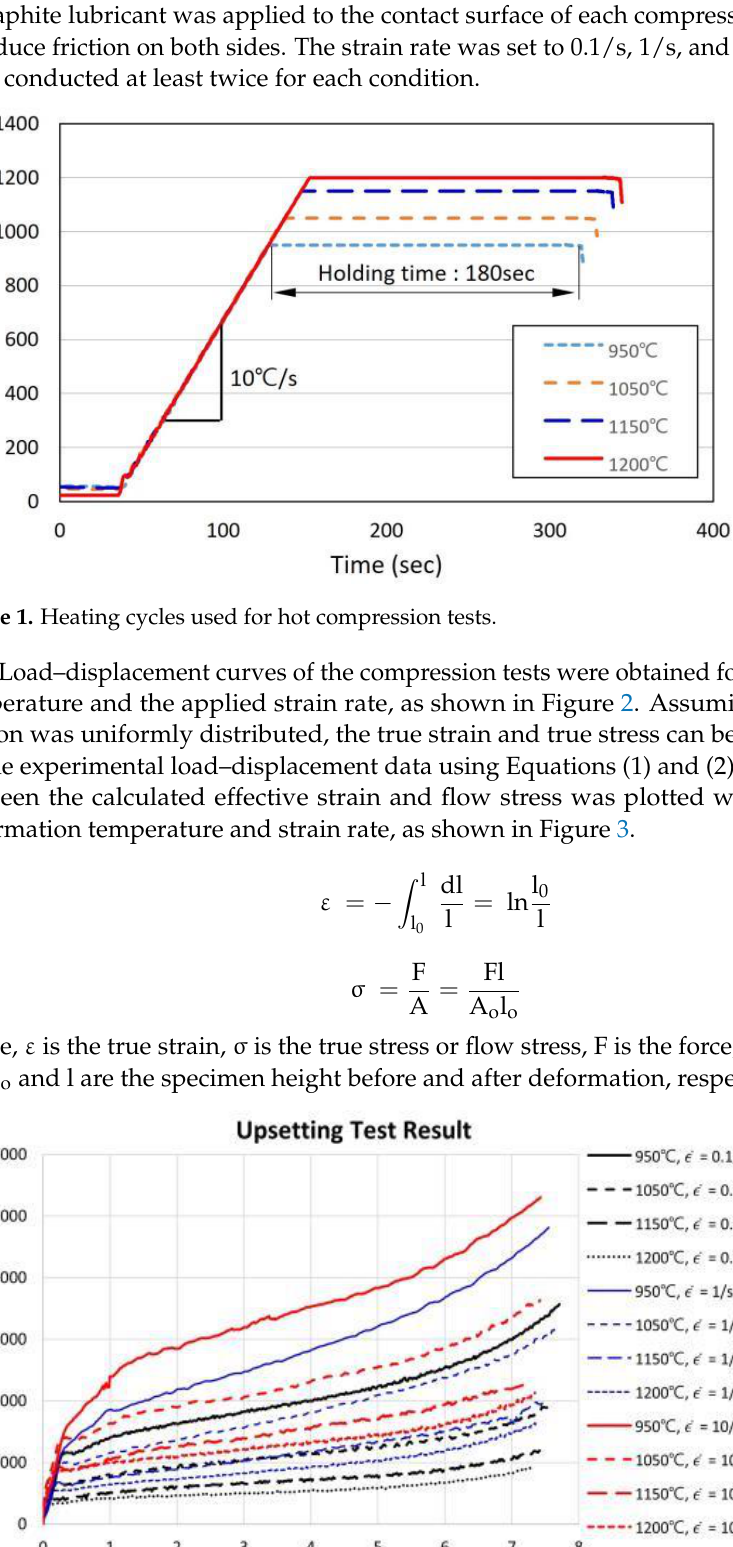
Figure 2. Load and displacement data obtained from compression tests.